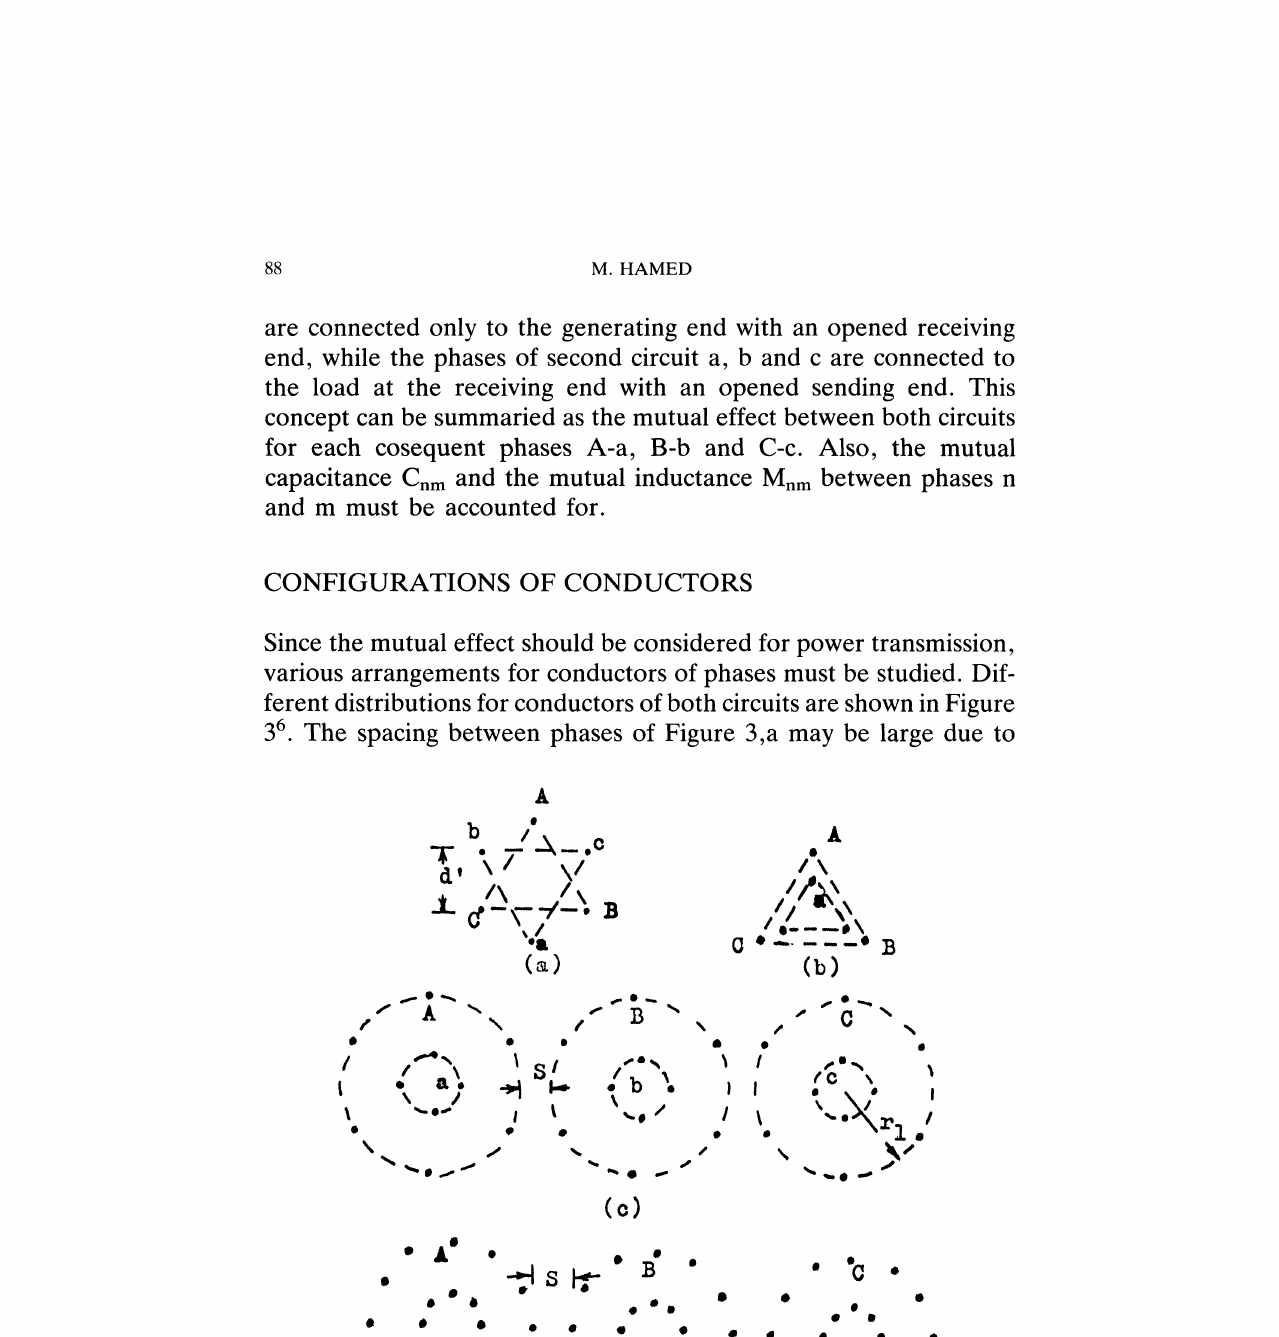
FIGURE 3 Different configurations for phases of the suggested type of transmission